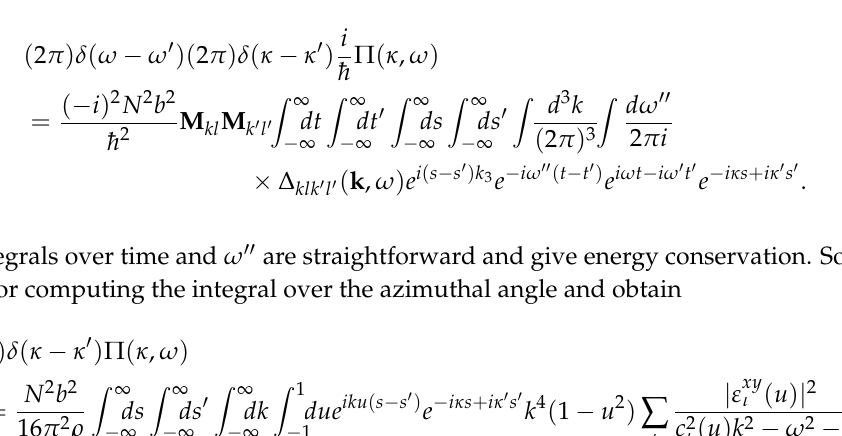
Figure 3. Diagrammatic representation of the dislon self-energy Π , where the dashed “external” lines carry ingoing and outgoing momenta κ and frequency ω